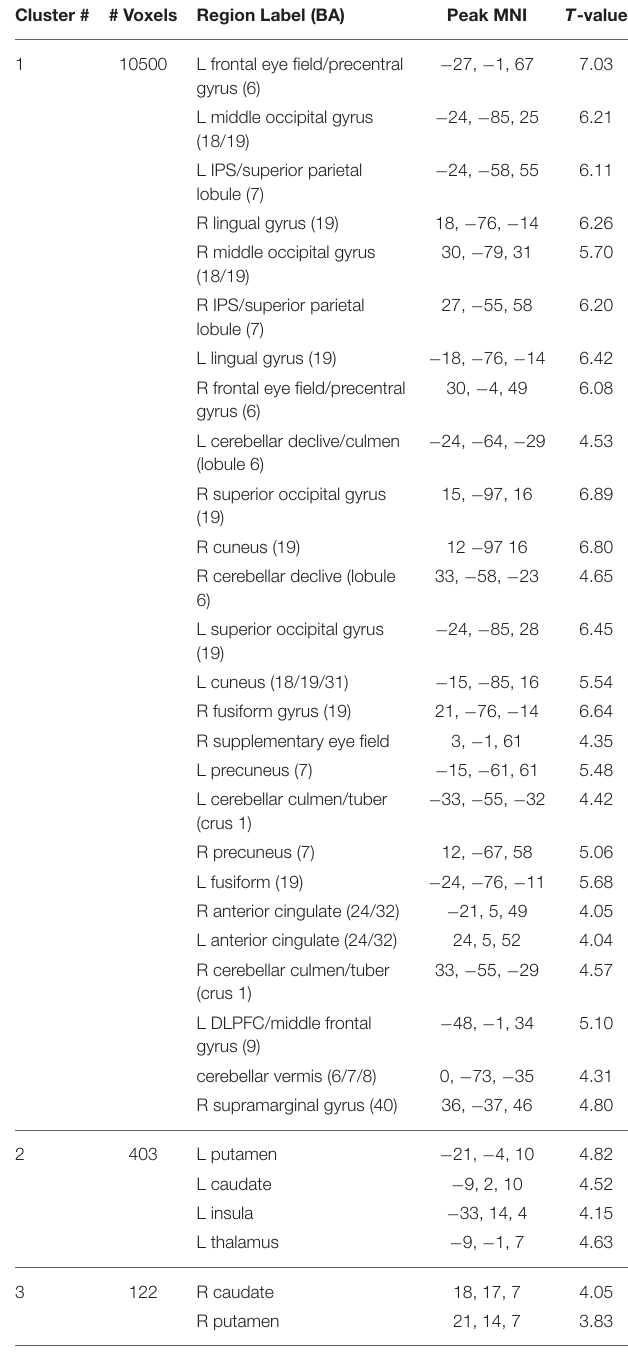
TABLE 2 | Peak MNI coordinates, t -values and region labels for the antisaccade session 2 > session 1 whole brain contrast. Cluster # # Voxels Region Label